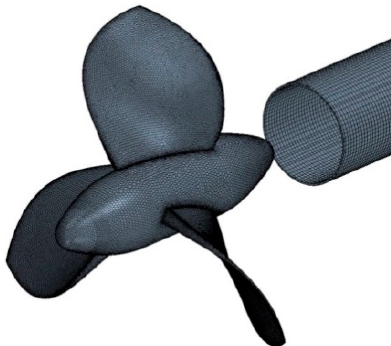
Figure 4. Mesh on the propeller and aeration pipe.